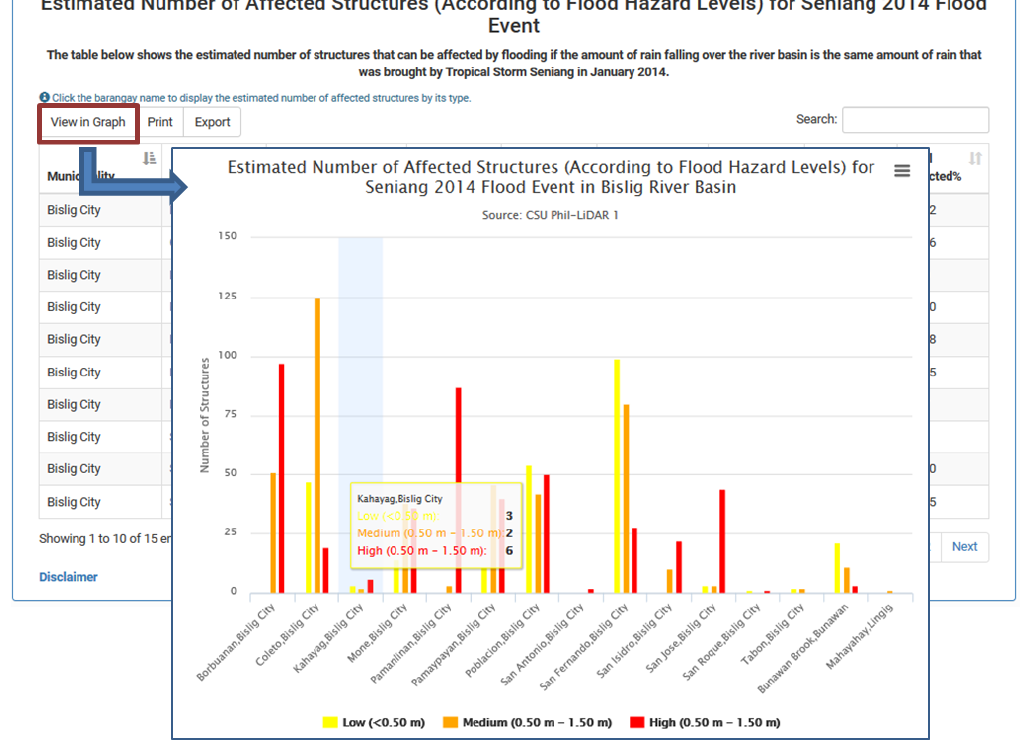
Figure 8. A graph can also be generated based on the computed flood hazard statistics.